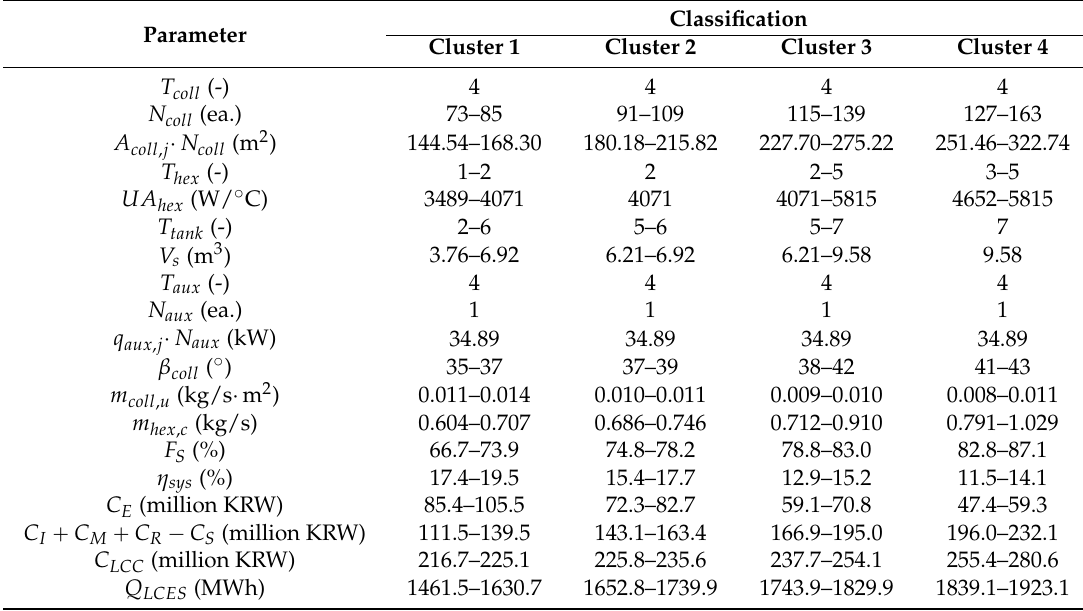
Table 3. Characteristics of non-dominated solutions for last generation for different clusters.